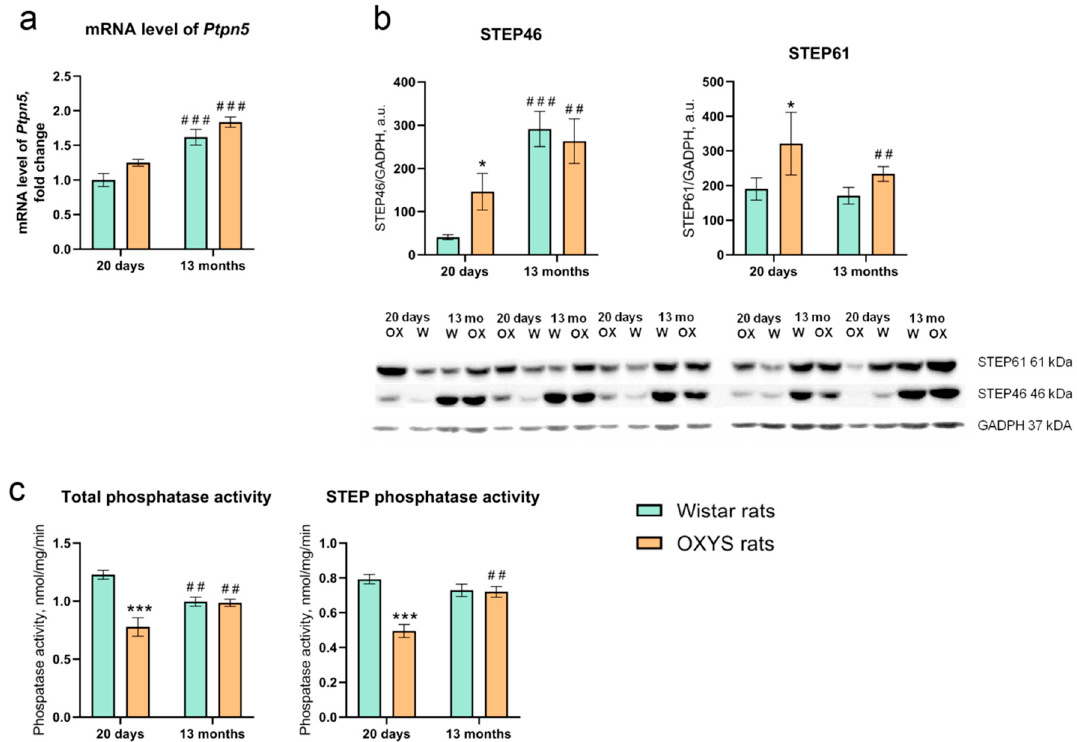
Figure 1. Age-dependent alterations of Ptpn5 mRNA expression (gene expression is presented as a fold change relative to 20-day-old Wistar rats) ( a ), STEP46 and STEP61 protein levels ( b ), and total phosphatase and STEP phosphatase activities ( c ) in the retina of OXYS rats compared with Wistar rats at 20 days and 13 months of age. Data are presented as the mean ± SE, n = 5. Significant differences between Wistar and OXYS rats: * p < 0.05; 1; *** p < 0.001; 20 days vs. 13 months for the same strain; ## p < 0.01; ### p < 0.001.